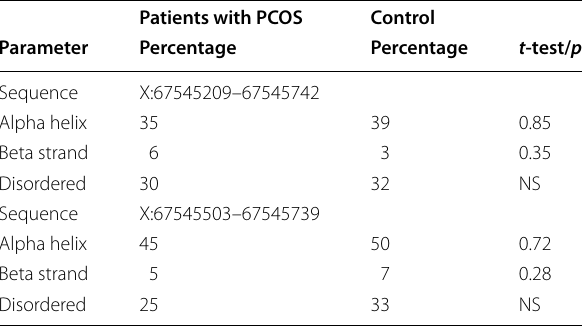
Table 4 Parameters related to secondary protein structure